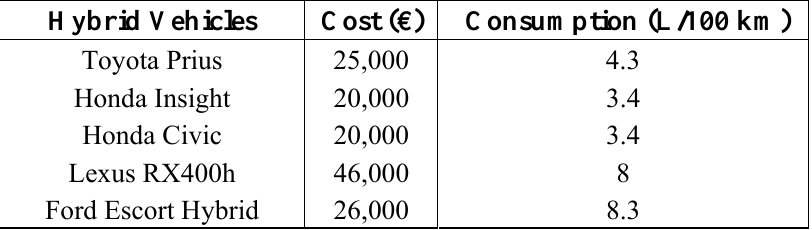
Table 12. Costs and consumption of some hybrid vehicles [13].